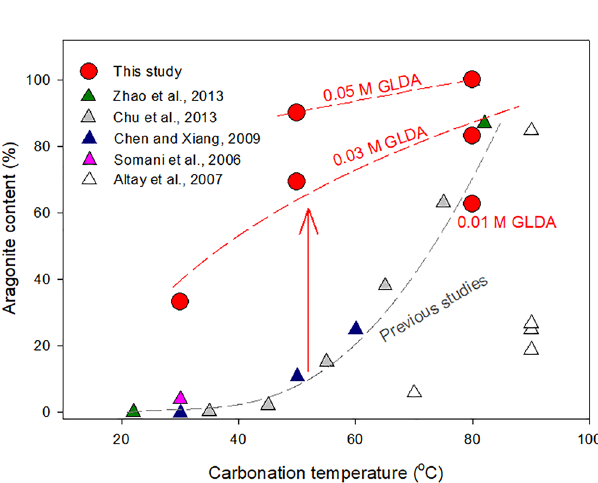
Figure 11. Effects of carbonation temperature on aragonite purity obtained in the present study and other works 3,18,19,48,49